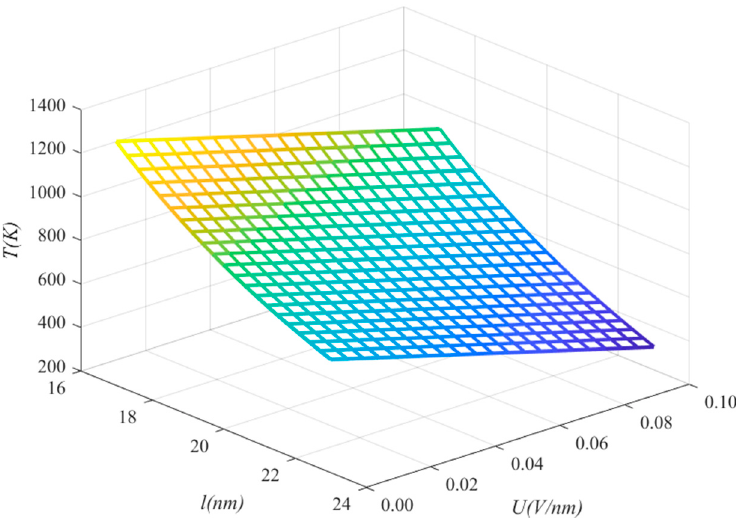
Figure 2. Critical temperature of the buckling as a function of critical electric field and critical length.